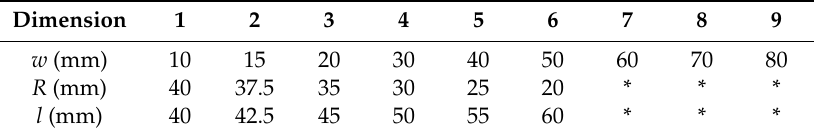
Figure 6. Specimens ’ shape designs. Table 2. Specimen sizes.